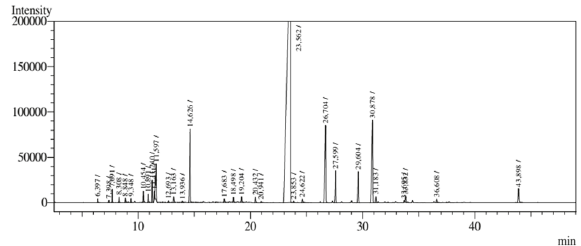
Figure1:GC-MSchromatogramanalysis C.zeylanicum essentialoil stems (EOCz).